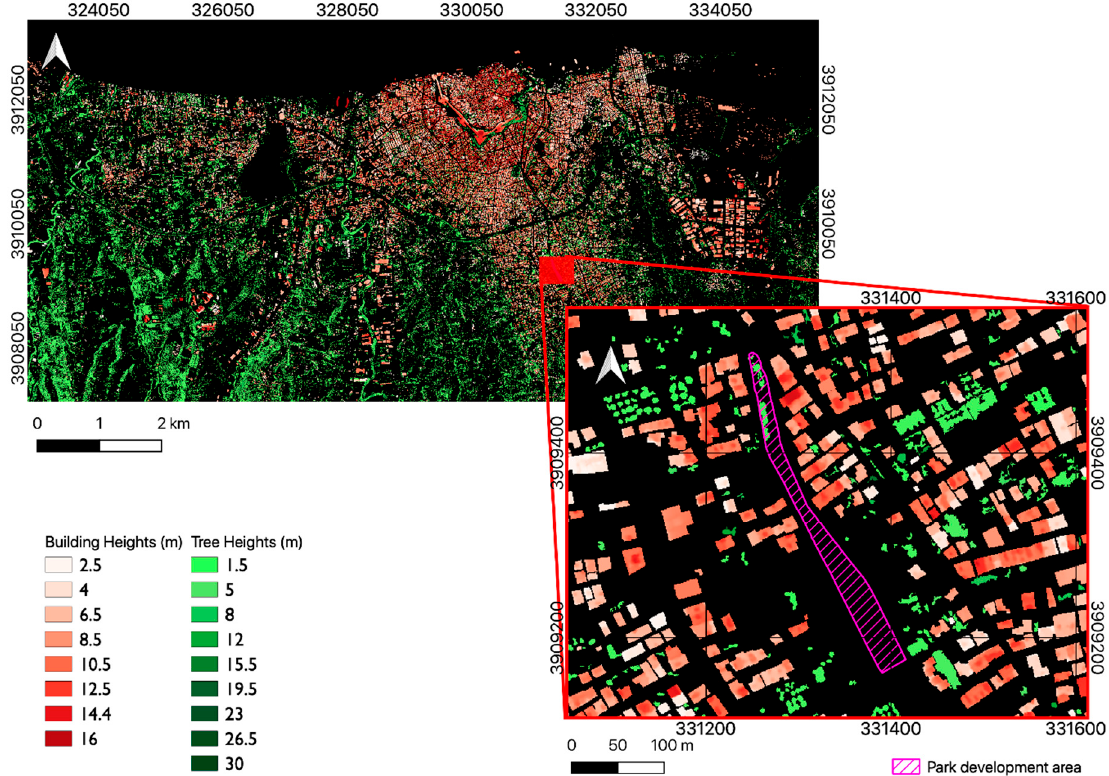
Figure 11. Building and tree height layer overlay of Heraklion and the area of the park.